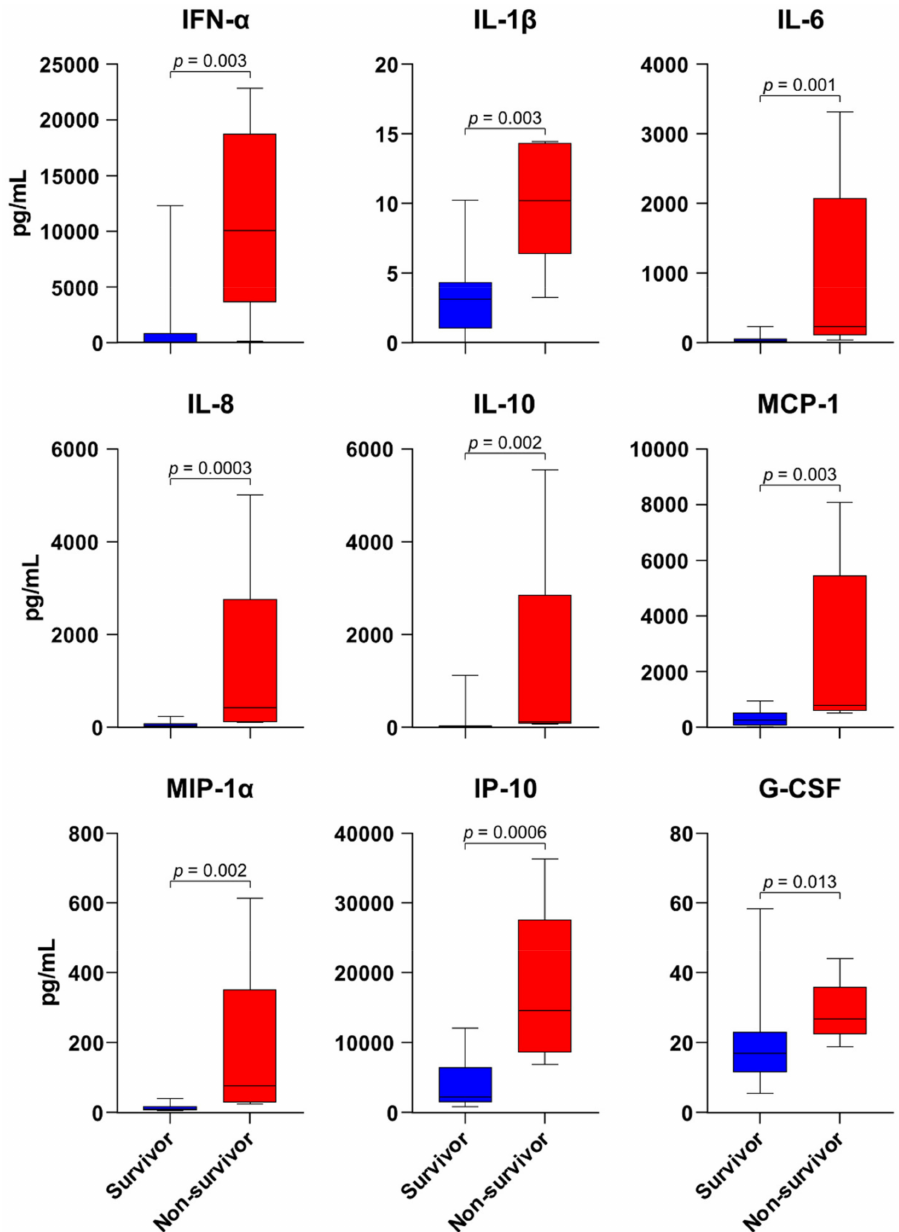
Figure 2. Initial plasma concentrations of cytokines and chemokines in patients with SFTS. The plasma concentrations of IFN- α , IL-1 β , IL-6, IL-8, IL-10, MCP-1, MIP-1 α , IP-10, and G-CSF on hospital days 1–2 in non-survivors were significantly higher than those in the survivors. Blue, survivor; red,